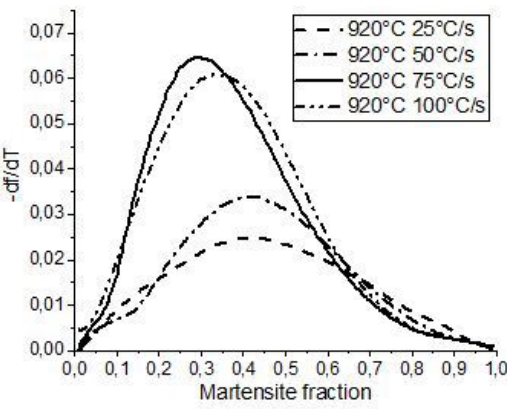
Figure 18. Martensitic transformaion rate as a function of the cooling rate. Austenitizing temperature of 920°C.